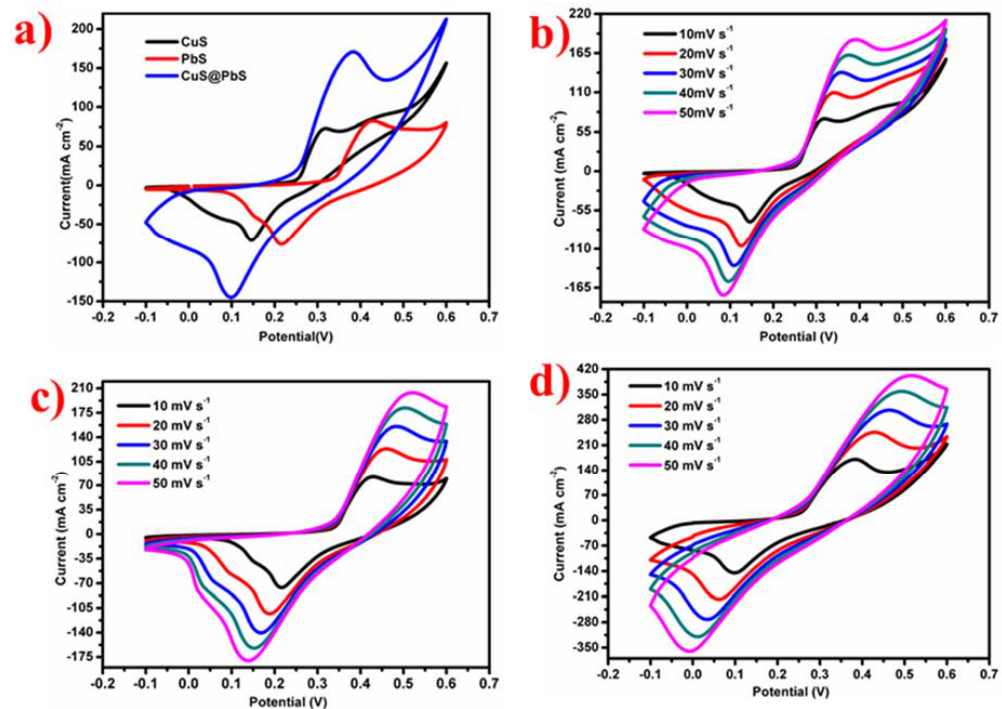
Figure 5. ( a ) Comparison CV curves of the CuS, PbS and CuS@PbS electrodes at the scan rate of 10 mV s − 1 . CV curves of the ( b ) CuS, ( c ) PbS, ( d ) CuS@PbS electrodes at different scan rates of 10–50 mV s − 1 in 3 M KOH solution.